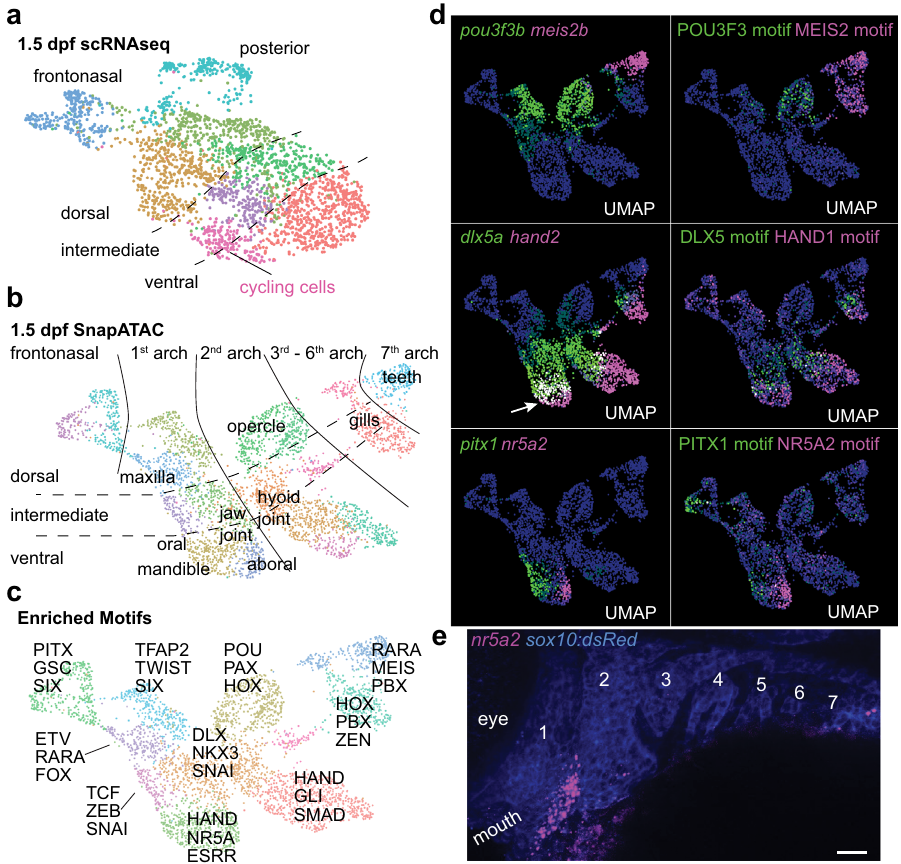
Fig. 3 Highly resolved embryonic spatial expression domains from integrated datasets. a , b , UMAPs at 1.5 dpf generated by scRNAseq versus integration of scRNAseq and snATACseq datasets using SnapATAC. SnapATAC outperforms scRNAseq in resolving dorsoventral (vertical), anterior- posterior (horizontal), and major arch landmarks including a previously unappreciated oral-aboral axis in zebra fi sh. c Select enriched transcription factor binding motifs for each cluster. d Gene body activities for transcription factors and their corresponding DNA-binding motifs reveal tight correspondence with published expression patterns, including zebra fi sh-speci fi c overlap of dlx5a and hand2 in the mandibular arch (arrow). e Fluorescent in situ hybridization shows restricted expression of nr5a2 in the aboral domain of the mandibular arch as predicted by SnapATAC. sox10:dsRed labels CNCCs of the arches in blue (numbered, anti-dsRed antibody stain). Scale bar, 20 μ